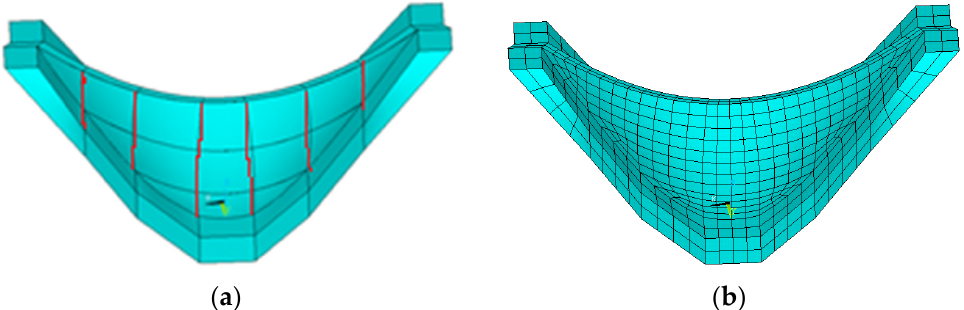
Figure 14. The computing model of arch-dam contact problem. ( a ) Layout of transverse joints. ( b ) Surface elements.